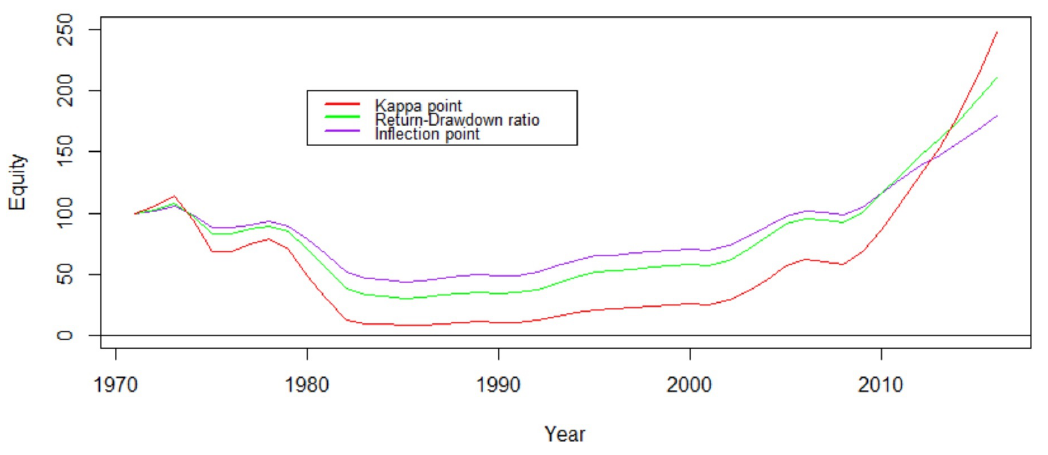
Figure 10. Equity for κ -red, ζ -blue, and ν -green vs. year in x-axis. Fixing